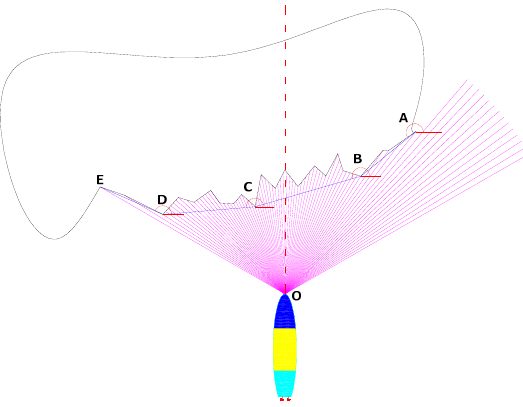
Figure 7. Obstacle detected surface disposed by LPAA.